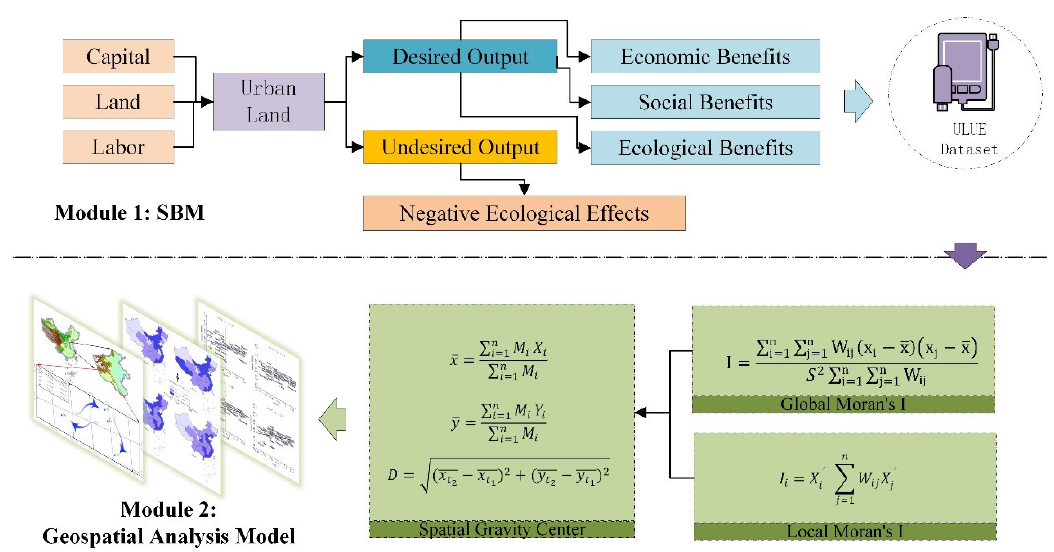
Figure 2. The structure of SBM-GPA model.